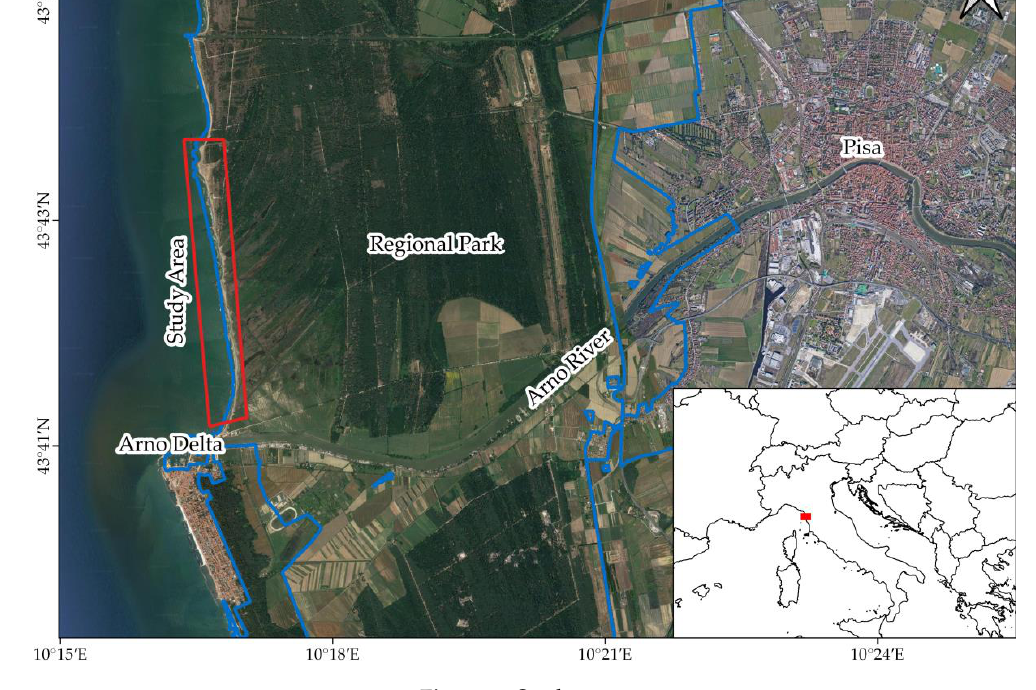
Water 2020 , 12 , x FOR PEER REVIEW